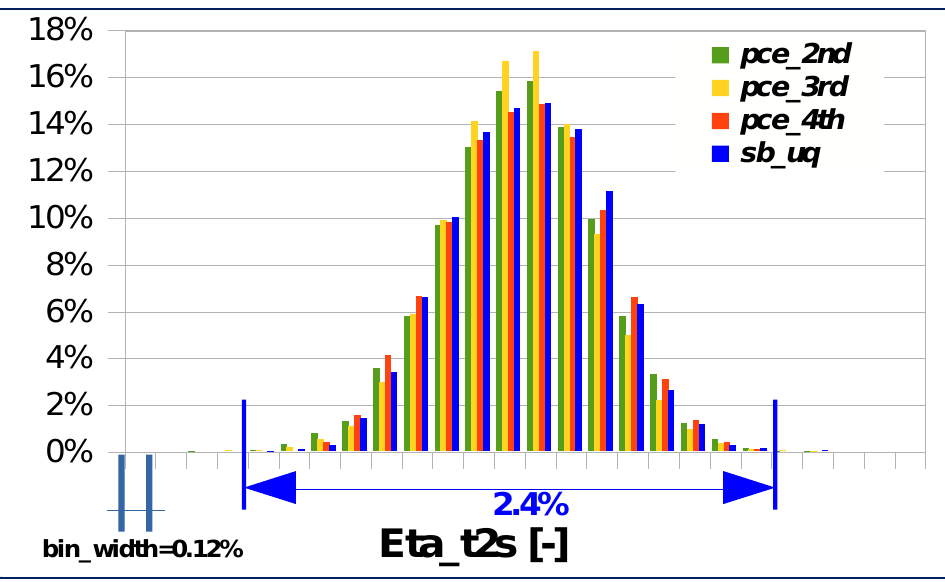
Figure 13. PCE vs. SB-UQ: overall efficiency probability distributions coming from different polynomial orders